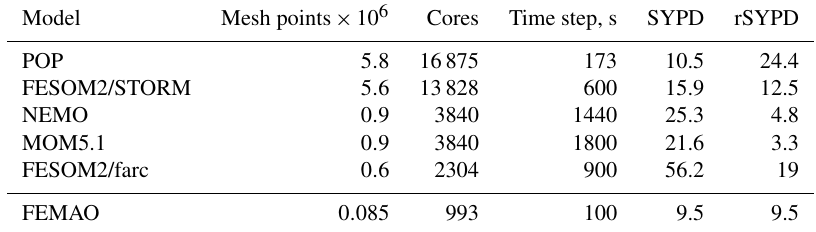
Table 5. Efficiency of the time step loop for the FEMAO model compared to global ocean–ice models. Rescaled SYPD (rSYPD, Eq. 13) accounts for the difference in time steps and the number of horizontal mesh points and CPU cores. Original values are published in Koldunov et al. (2019a), Huang et al. (2016), and Ward (2016), but we took our values directly from Table 3 in Koldunov et al.